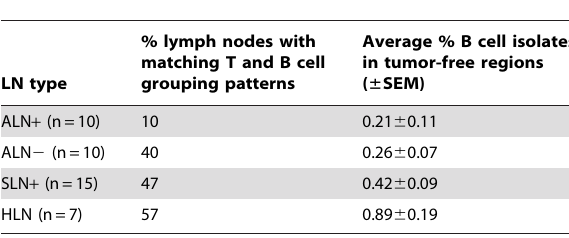
Table 1. Comparison of the percentages of lymph nodes found with matching spatial grouping patterns of T and B cells and the average proportion of B cell isolates in tumor- free